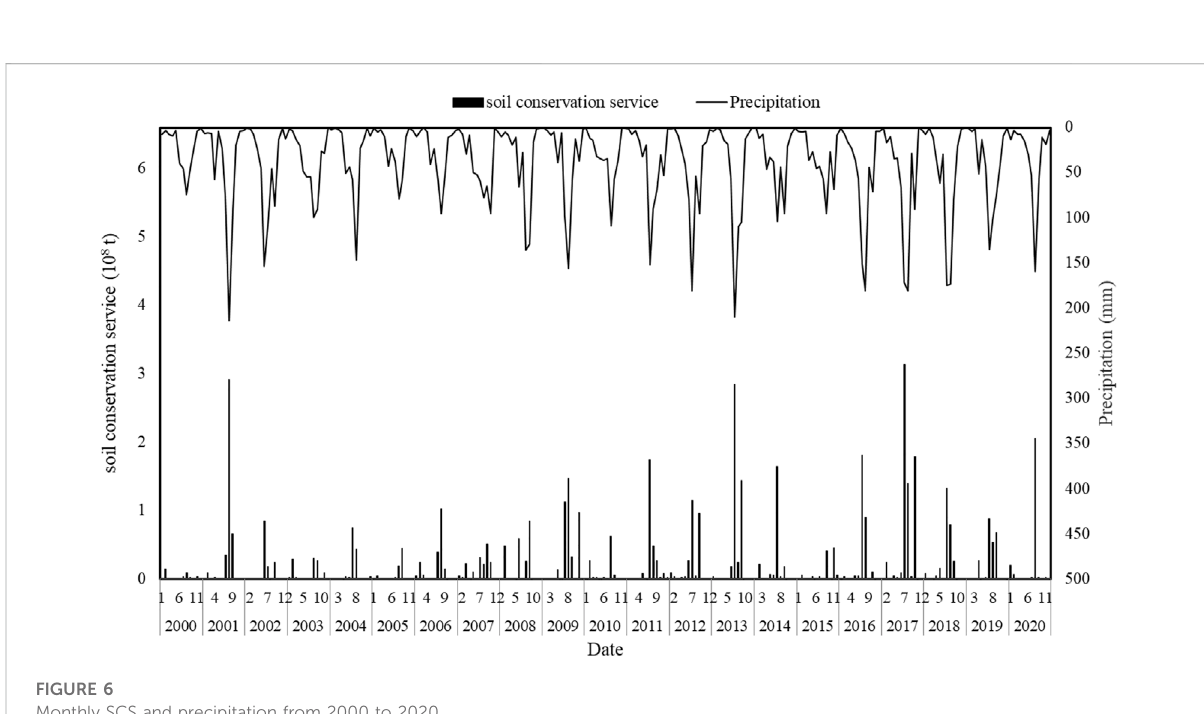
FIGURE 6 Monthly SCS and precipitation from 2000 to